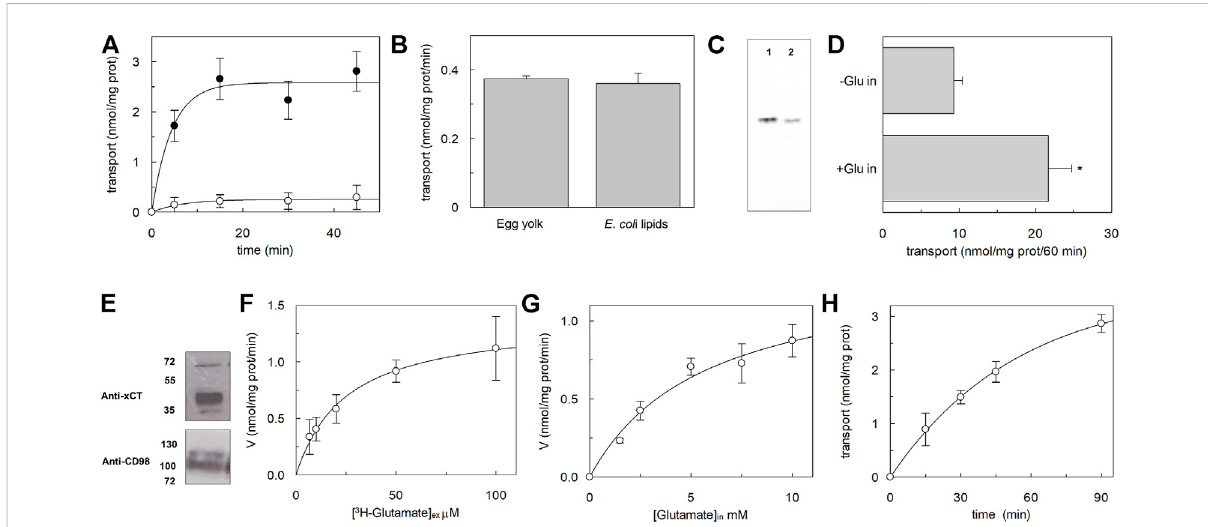
FIGURE 4 Biochemical characterization of hxCT reconstituted in proteoliposomes. In (A) , time course analysis of reconstituted xCT. Puri fi ed protein was reconstituted as described in materials and methods. The transport was started by adding 10 μ M [³H]-glutamate to proteoliposomes without (o) or with10 mMinternalglutamate( C ),andstoppedatindicatedtimes.Dataareplottedusing fi rstorderrateequation.Dataarepresentedasmean±SD of four independent experiments. In (B) , effect of E. coli lipids. Puri fi ed protein was reconstituted as described in materials and methods. The transport was started by adding 10 μ M [³H]-glutamate to proteoliposomes prepared with phosphatidyl choline from egg yolk or with a mixture of phosphatidyl choline from egg yolk and bacterial lipids (70:30). The transport was stopped after 20 min. In (C) , Western blot analysis. The puri fi ed protein(lane1)andreconstitutedprotein(lane2)wereloadedontoa12%SDS-PAGEforWesternblotanalysiswithanti-Hisantibody.In (D) ,transport of native xCT extracted from A549 cells. Cell extracts were prepared and reconstituted as described in materials and methods. The transport was started by adding 10 μ M [³H]-glutamate to proteoliposomes without or with 10 mM internal glutamate and stopped after 60 min as indicated in the fi gure. *Signi fi cantly different from the control (-Glu in) as estimated by Student ’ s t -test ( p < 0.01). In (E) Western blot analysis. The A549 pellet was solubilizedasdescribedinmaterialandmethodsand50 μ gwereloadedontoa12%SDS-PAGEforWesternblotanalysiswithindicatedantibodies.In (F,G) kinetic analysis of the recombinant xCT reconstituted in proteoliposomes as described in materials and methods. In (F) , the transport was measured in 10 s by adding indicated concentrations of [³H]-glutamate to proteoliposomes containing 10 mM internal glutamate, for evaluation of external Km for glutamate. In (G) , the transport was measured in 10 s by adding 10 μ M [³H]-glutamate to proteoliposomes containing indicated concentrations of internal glutamate, for evaluation of internal Km for glutamate. Data are plotted using the Michaelis-Menten equation. Data are presented as mean ± SD of three independent experiments and transport rate is measured as nmol/mg prot/min (V). In (H) , time course analysis of reconstituted xCT. Puri fi ed protein was reconstituted as described in materials and methods. The transport was started by adding 10 μ M [³H]- glutamatetoproteoliposomescontaining5 mMinternalcystineandstoppedatindicatedtimes.Dataareplottedusing fi rst-orderrateequation.Data are presented as mean ± SD of three independent